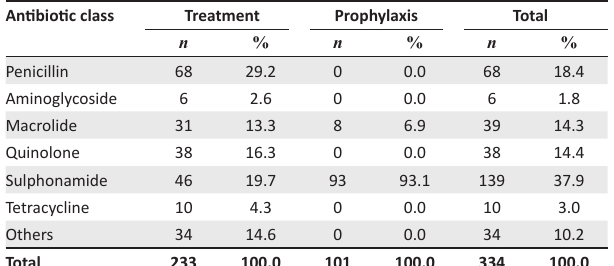
TABLE 4: The choice for prescribing a class of antibiotic.